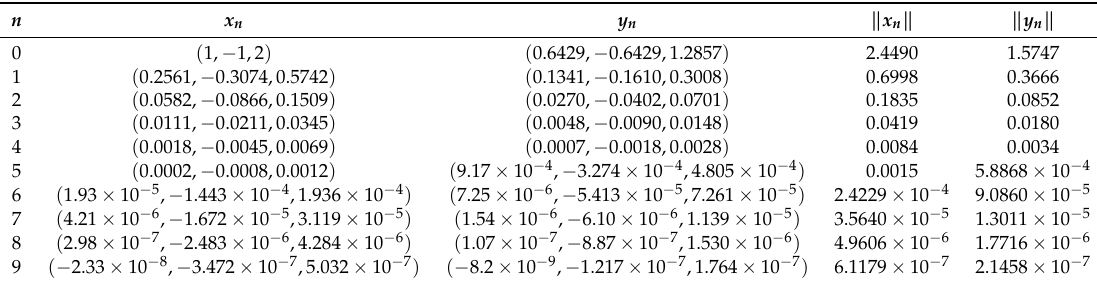
Table 2. The convergence of Algorithm